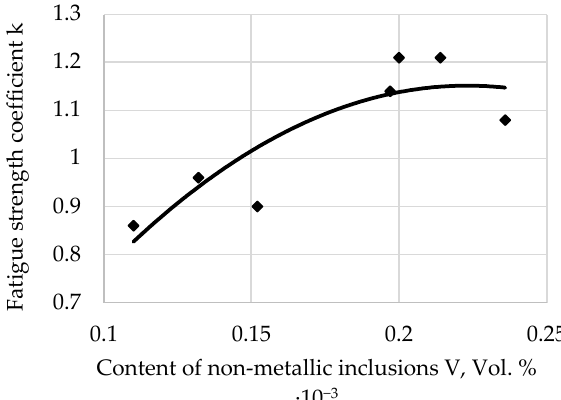
Figure 2. The bending fatigue strength coefficient, k , of research steel after hardening and tempering at 200 °C depends on the relative content of non-metallic inclusions.